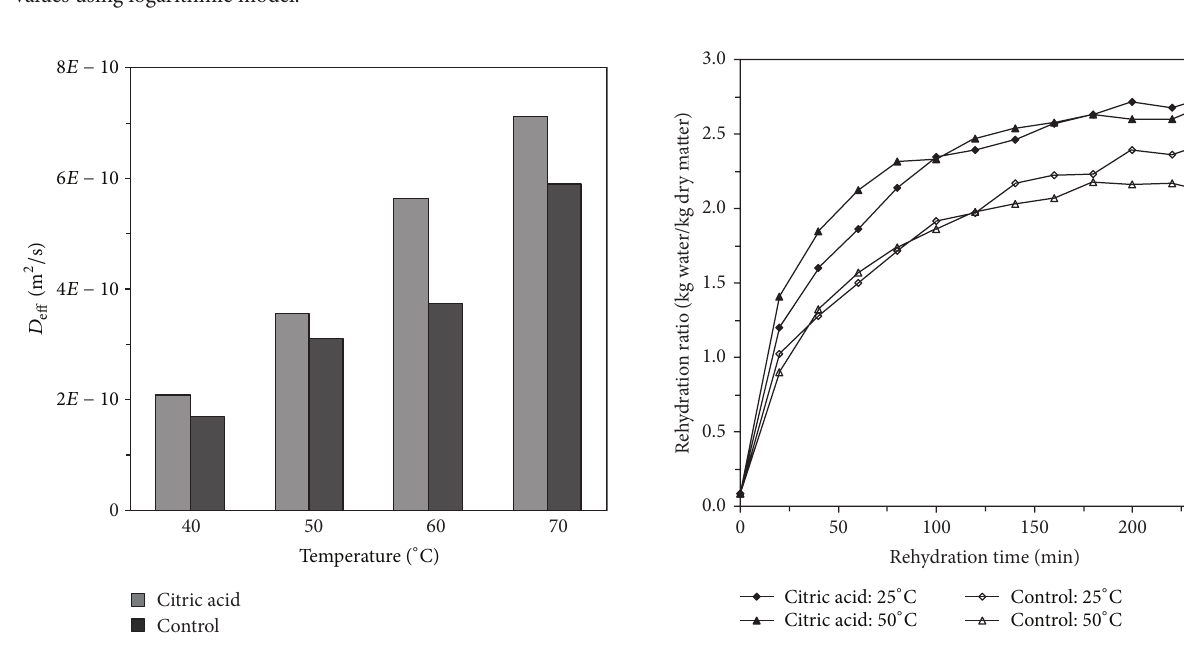
Figure 4: Variation of effective moisture diffusivity with drying air temperature.